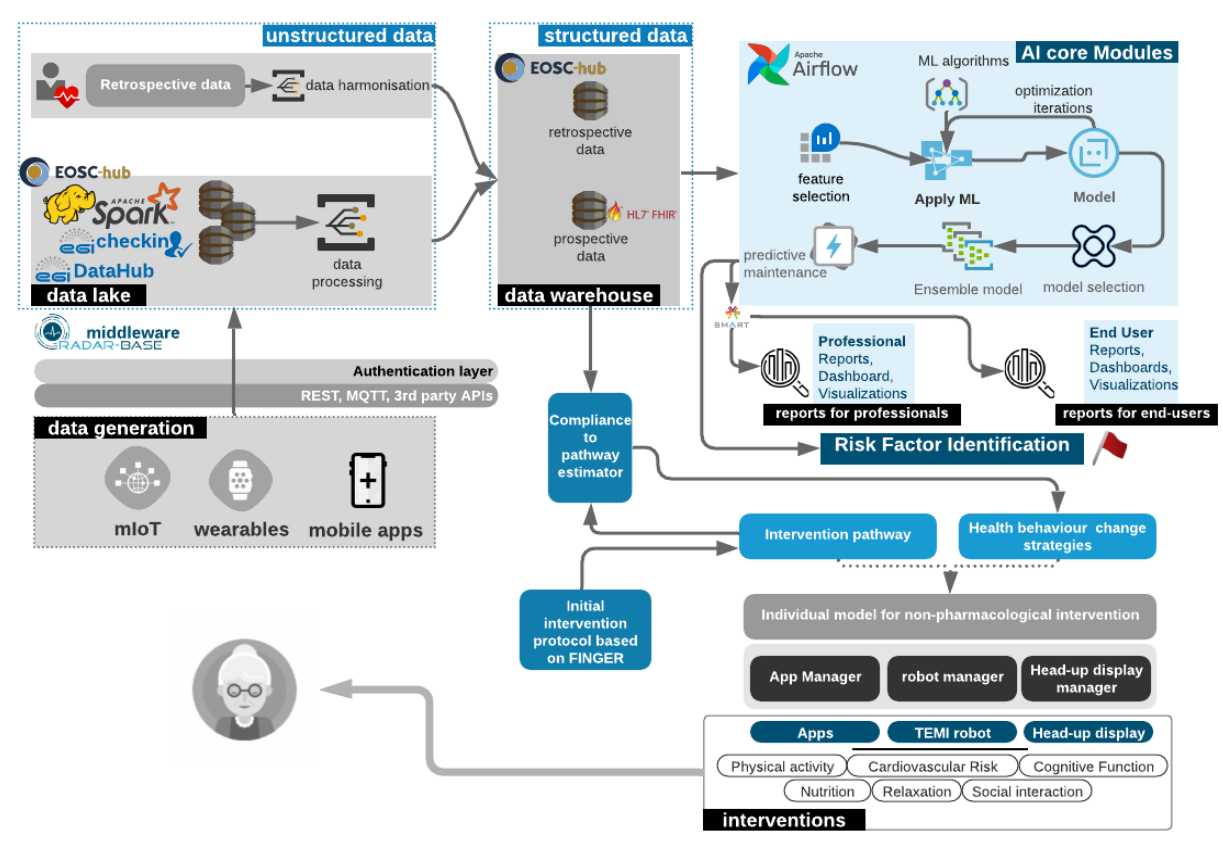
Figure 2. LETHE detailed technical Figure 4: LETHE detailed technical architecture